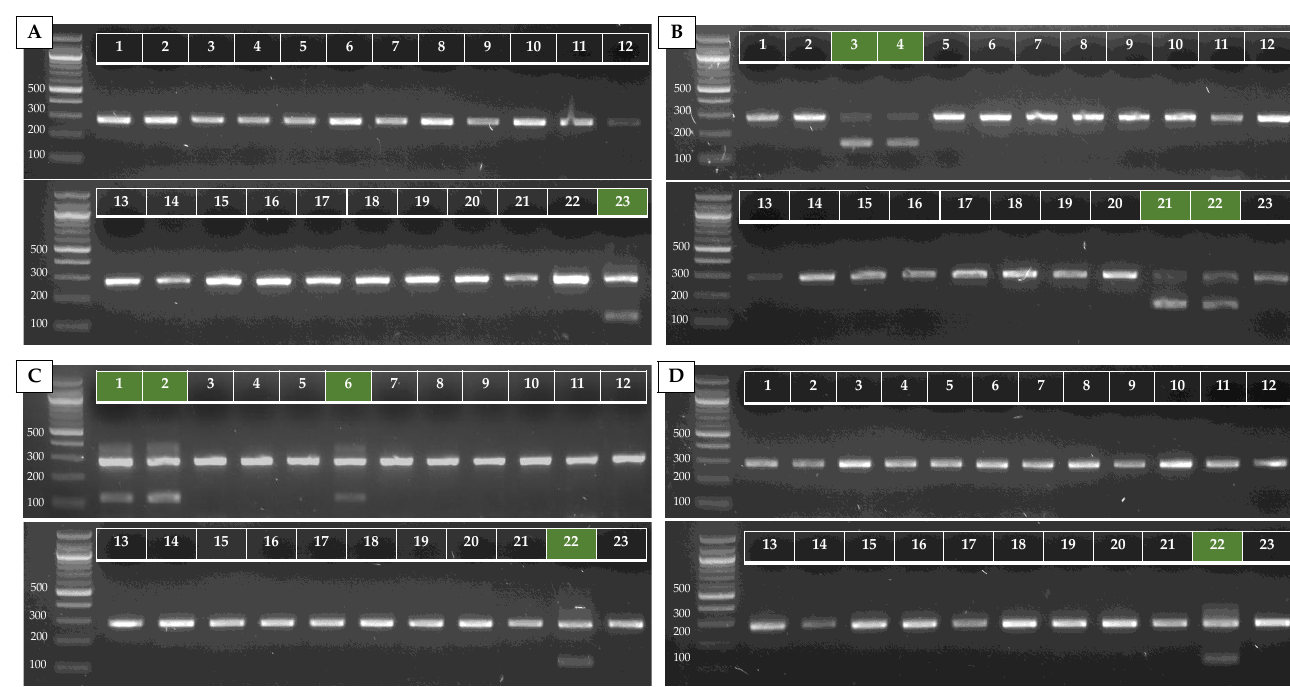
Figure A2. AS-PCR results of the four clade-specific PCRs for 23 strains of C. auris from our in-house collection, represented by the numbers 1 – 23 (see Table A2). Duplex PCRs of the ITS1 – ITS_Cau_R and ITS1 – ITS_CauCII_R ( A ), RHA1 _CauCIII/V_F– RHA1_CauCIII/V_R ( B ), ITS1 – ITS_CauCIV/V_R ( C ), and ITS1 – ITS_CauCV_R ( D ) primer pairs at 68 °C Ta on 20 ng of purified DNA are shown. The green markings indicate where a positive result should appear.